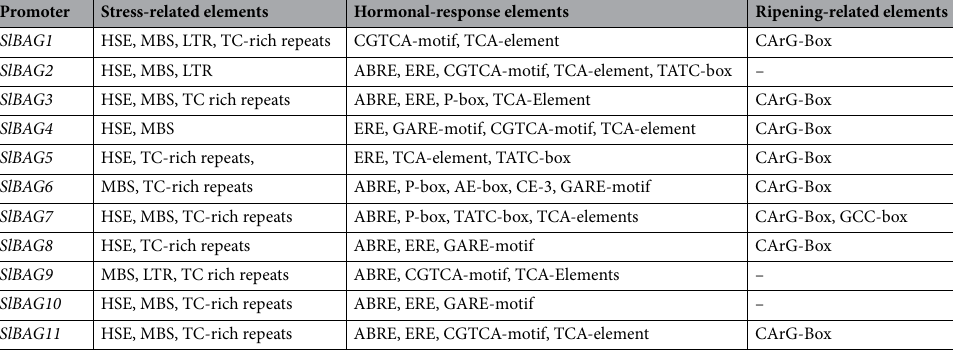
Table 2. Cis-acting elements located on SlBAGs